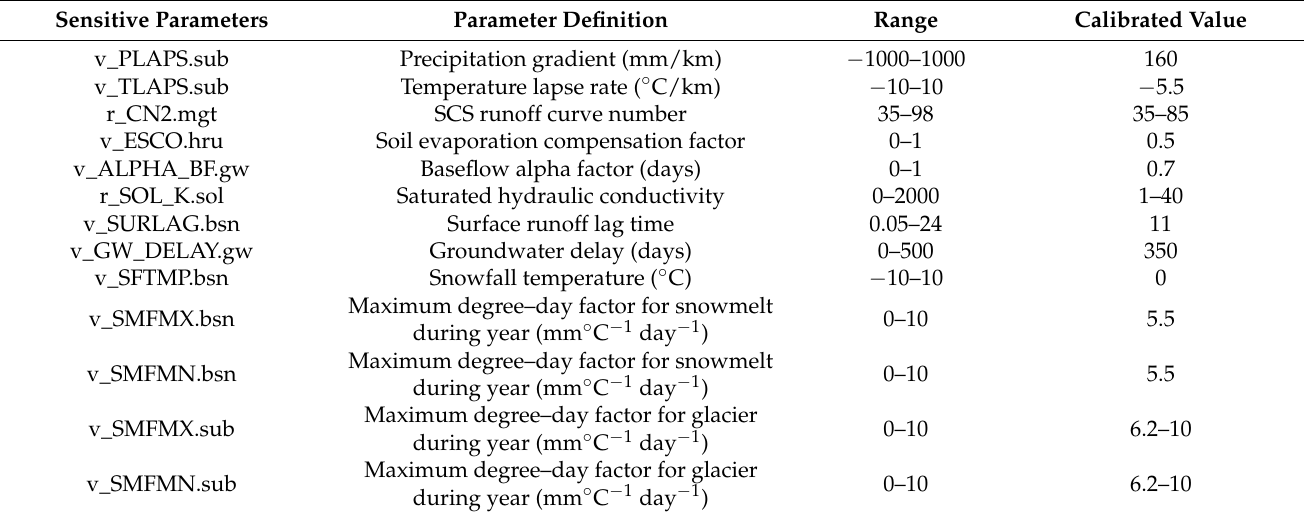
Table 4. Sensitive parameters for runoff simulation and calibration in